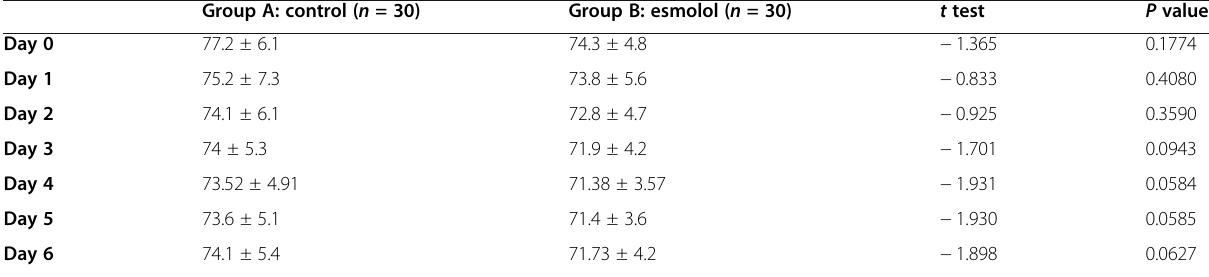
Table 7 Comparison between both groups according to ScvO2 %